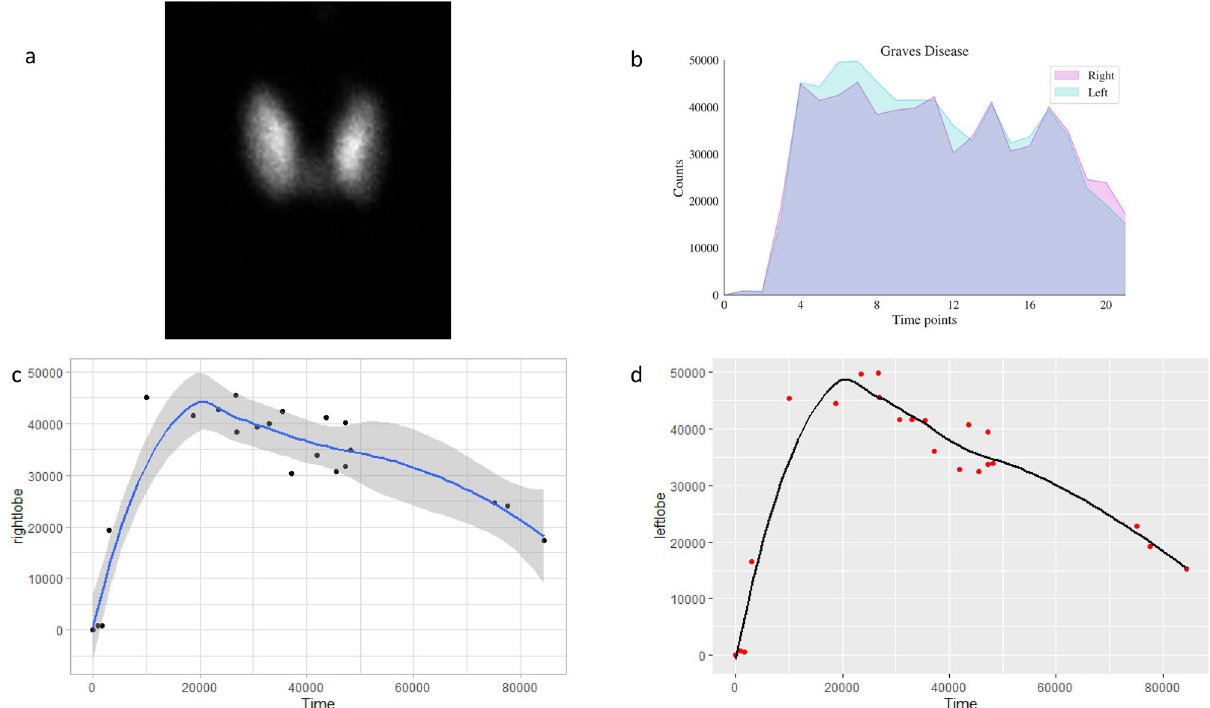
Figure 1. (Graves Patient 1) ( a ) 123 scan showing diffuse heterogenous uptake in both the lobes ( b ) superimposed uptake in the right and left side showing near similarity ( c ) Uptake (absolute counts) in the right lobe with counts and trend over time (in seconds) ( d ) Uptake (absolute counts) in the left lobe with counts and trend over time (in seconds) (loess curves are shown above).